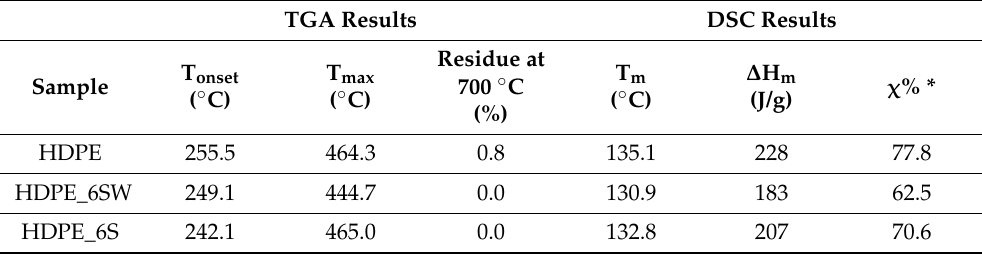
Figure 5. ATR spectra of: ( a ) HDPE, ( b ) PP, ( c ) PLA and ( d ) PBAT: raw granules in black; six ‐ months ‐ aged in seawater in blue; six ‐ months ‐ aged in sandbox in orange. The inset shows the enlargement of the spectra highlighted from the square. Table 5. Significant temperatures from TGA and DSC curves of HDPE